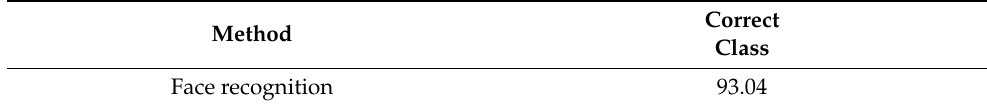
Table 3. Results for the initial face identification experiments by our